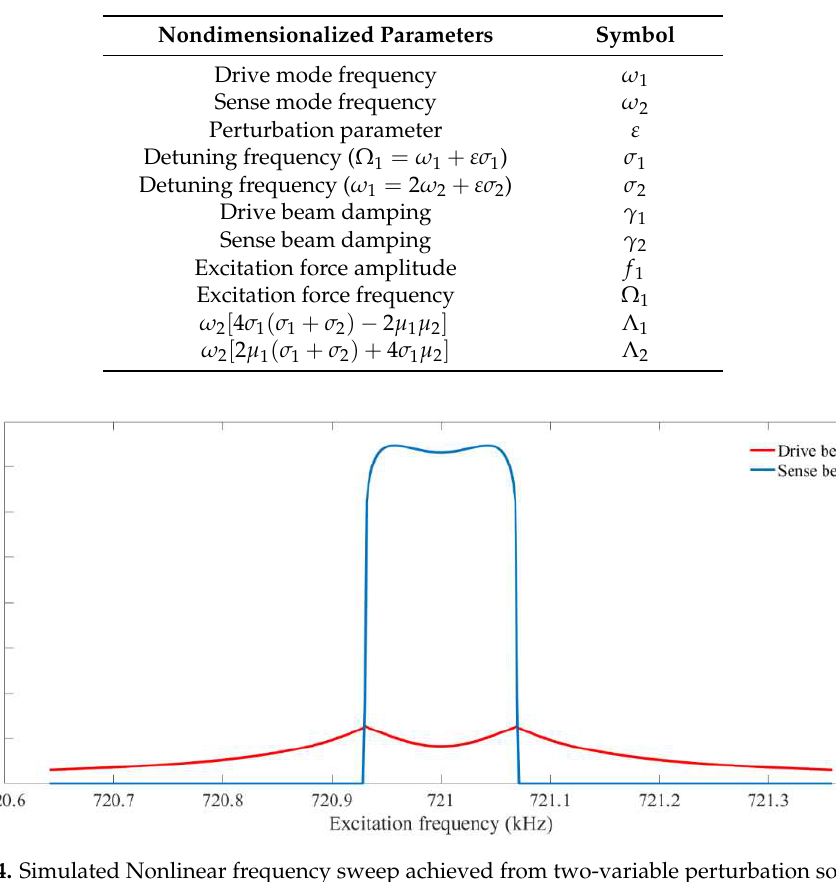
Table 1. Definition of nondimensionlized parameters for Equation (2).